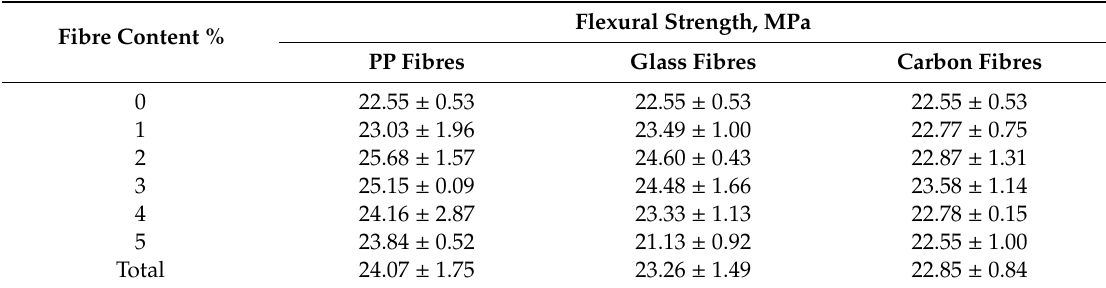
Table 4. List of average values of mortar flexural strength with standard